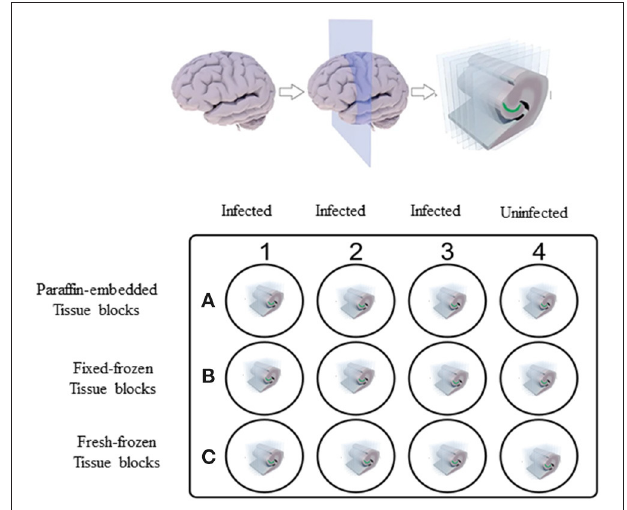
FIGURE 1 | Non-human primate (NHP) control tissue block preparation design. 0.6cm thick sections of NHP control brain tissues were placed in individual wells of 12-well plate containing 2ml of RPMI 1640 medium. Tissues in wells A1–A3, B1–B3, and C1–C3 were incubated with 1.0 × 10 7 /ml of spirochetes per well. Tissues in wells A4, B4, and C4 received culture medium alone. After overnight incubation, tissues from wells C1–C4 were washed in PBS and excess buffer was removed using kim wipes and tissues were embedded in OCT and flash-frozen in dry-ice ethanol bath and stored at − 80 ◦ C. Rest of the tissues in wells A1–A4 and B1–B4 were fixed. Tissues from wells A1–A4 were processed for paraffin-embedded blocks and tissues from wells B1–B4 were processed for Fixed-frozen